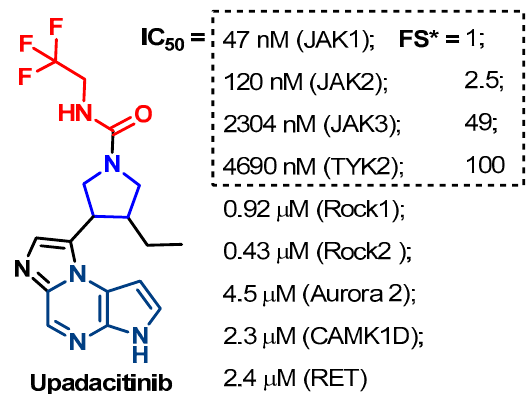
Figure 67. Kinase inhibitory activity of upadacitinib (* FS, fold selectivity compared to JAK1). In addition, the results of the kinase inhibitory assay of upadacitinib against 70 kinases revealed weak inhibitory activity against kinases other than JAKs [199].